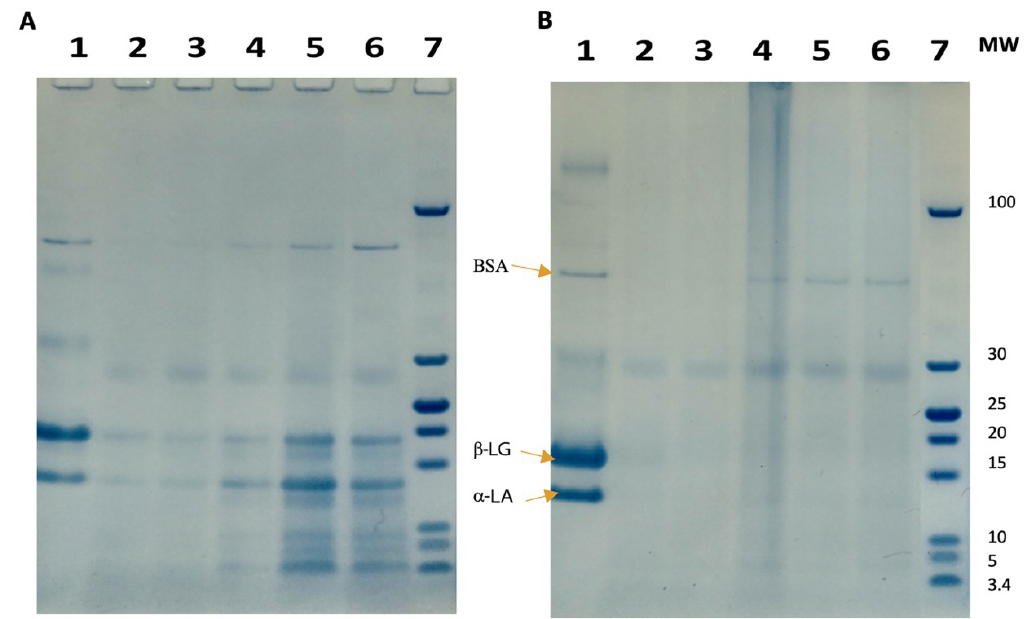
Figure 5. Sodium dodecyl sulphate polyacrylamide electrophoresis (SDS-PAGE) of tryptic hydrolysates of whey protein isolate following heating to 85 °C for 5 min at different pH values, using a heat exchanger, under ( A ) reducing conditions (1) WPI; (2) pH 6.5; (3) pH 7; (4) pH 7.5; (5) pH 8; (6) pH 8.5; (7) molecular weight marker; ( B ) SDS-PAGE under non-reducing conditions, (1) WPI, (2) pH 6.5; (3) pH 7; (4) pH 7.5; (5) pH 8; (6) pH 8.5; (7) molecular weight markers.